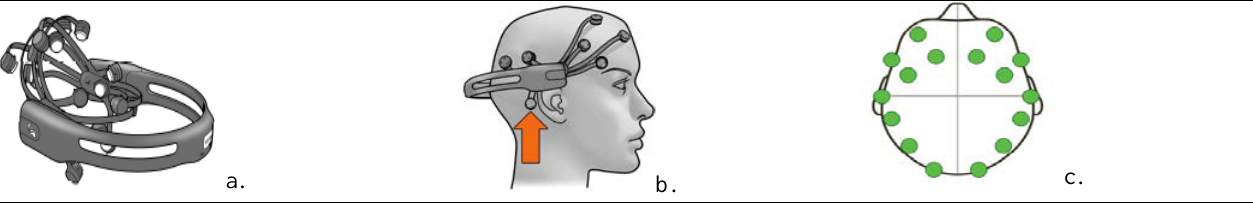
Figure 2. Emotiv SDK EEG equipment and respective sensor location